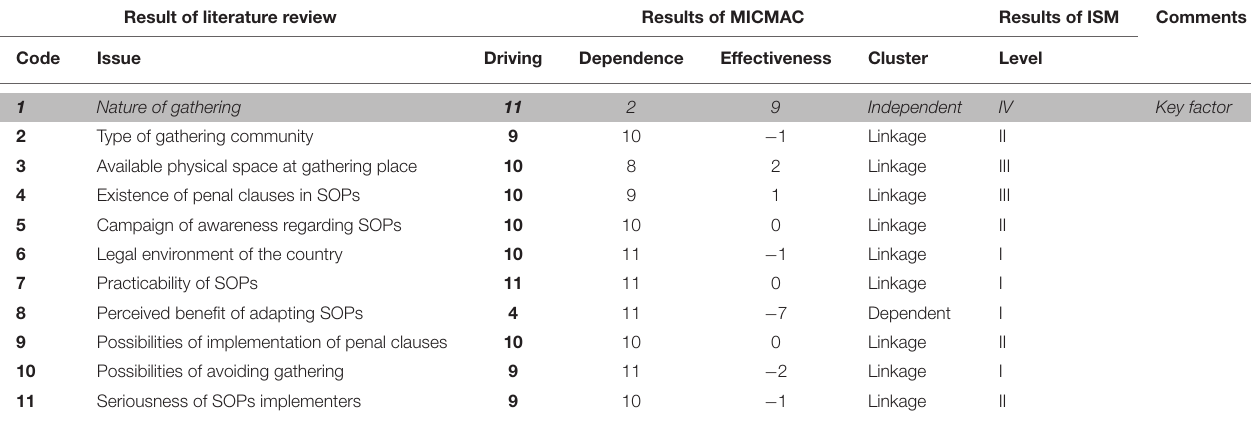
TABLE 11 | Summarized and juxtaposed results of the